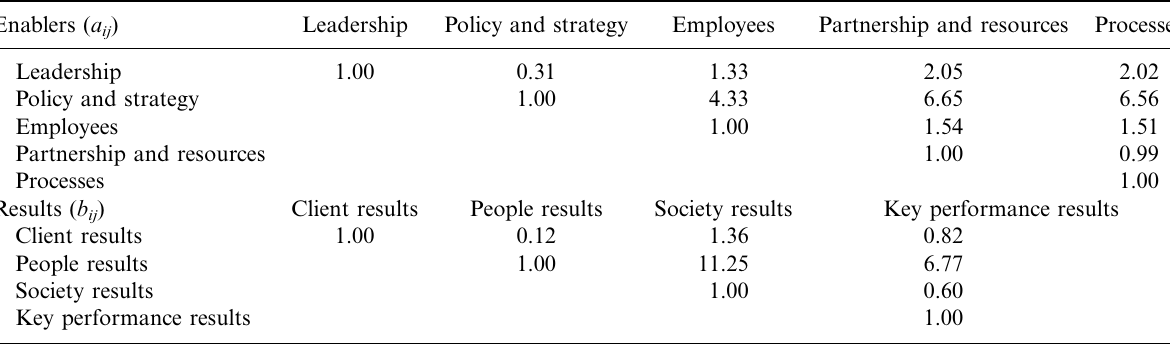
Table 4. Pair-wise weights for the AHP model for selecting strategic objectives Enablers ( a ij